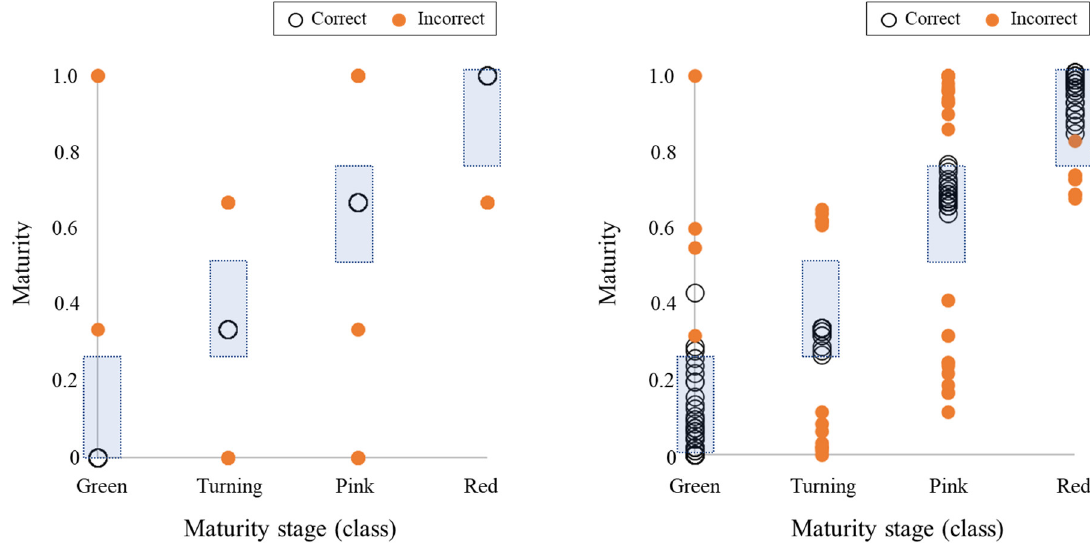
Figure 6. Tomato maturity estimations expressed as classification ( left ) and distribution ( right ).